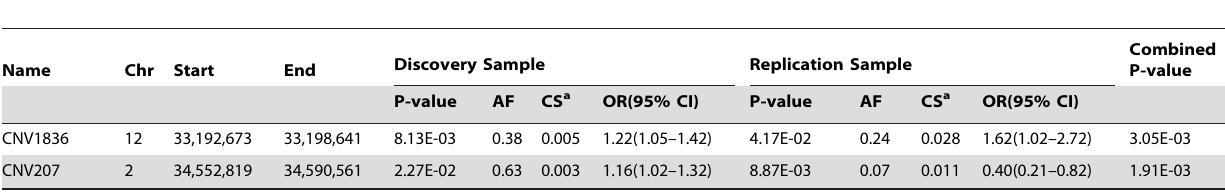
Table 2. Characteristics of the interesting CNVs for association